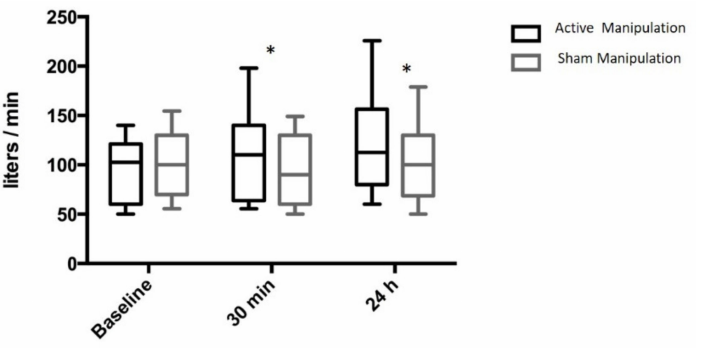
Figure 5. Variation of peak nasal inspiratory flow after active manual stimulation of the sphenopala- tine ganglion and after sham manual stimulation in OSAS patients. Results are median and 10–90 centiles. * p = 0.0001 Active versus Sham manipulation.